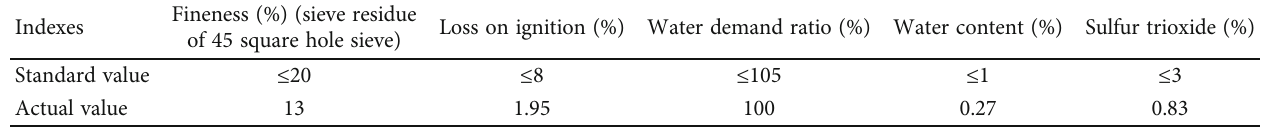
Table 1: The technical indexes of fl y ash.